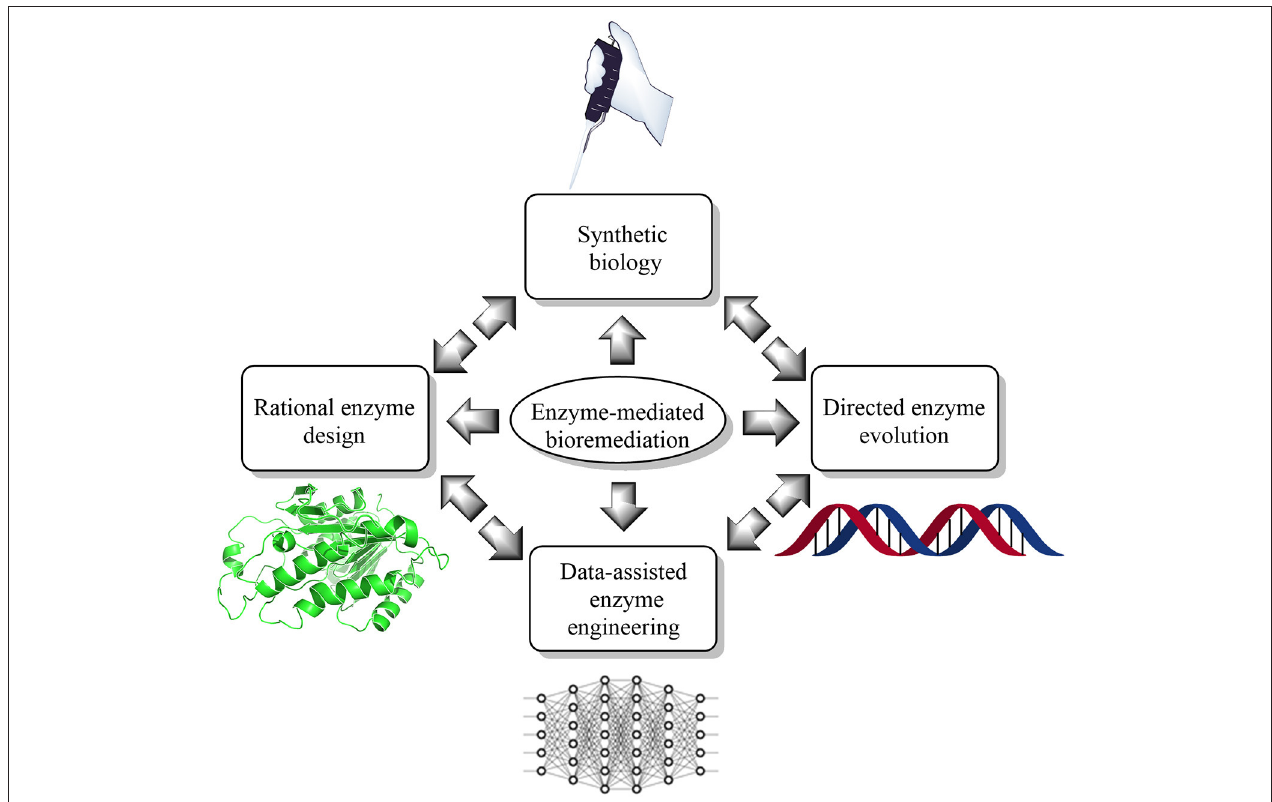
FIGURE 1 | Current state-of-the-art trends and technologies for enzyme-mediated bioremediation, which include synthetic biology (enzyme reengineering and redesigning in vitro ), rational enzyme design (molecular modeling and simulation), directed enzyme evolution (enhanced enzyme selection), and data-assisted enzyme engineering [artificial intelligence (AI) and machine learning